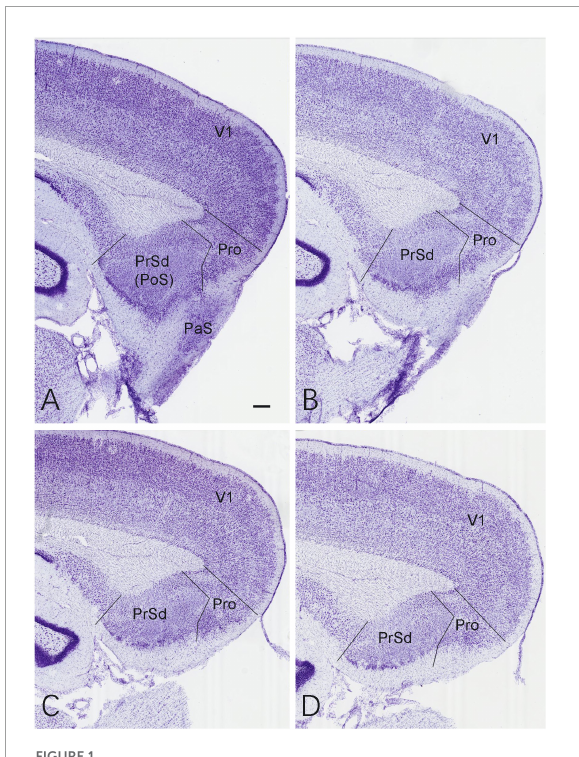
FIGURE1 Location and normal cytoarchitecture of the rat prostriata. (A–D) Sequential Nissl-stained sagittal sections from the lateral (A) to medial (D) levels of the prostriata and adjoining regions in a normal (control) rat. Bar in panel (A) : 200 µ m for all panels.